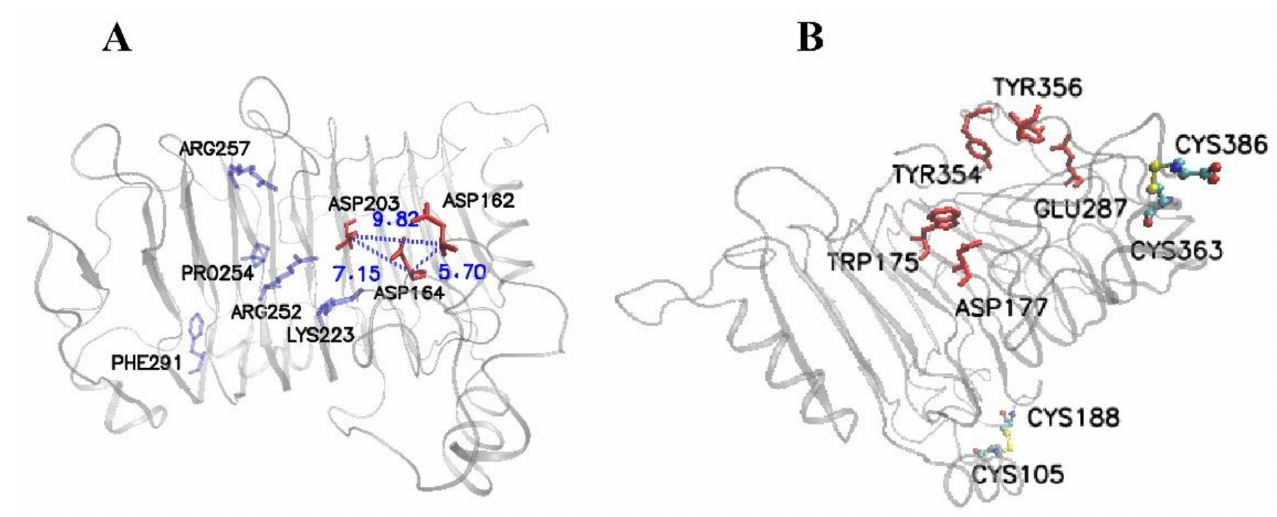
Figure 1. The conserved sites of PelG403. ( A ): The substrate binding pockets. The red sticks indicate the Ca 2+ binding sites (ASP162, ASP164 and AS203) and the blue sticks indicate substrate binding sites (LYS223, ARG252, PRO254, ARG257 and PHE291). ( B ): The highly conserved sites. The red sticks indicate the conserved sites associated with catalytic activity (TRP175, ASP177, GLU287, TYR354, and TYR356), and the two pairs of disulfide bonds formed by CYS105 vs. CYS188 and CYS363 vs. CYS386 positively affect the stability of